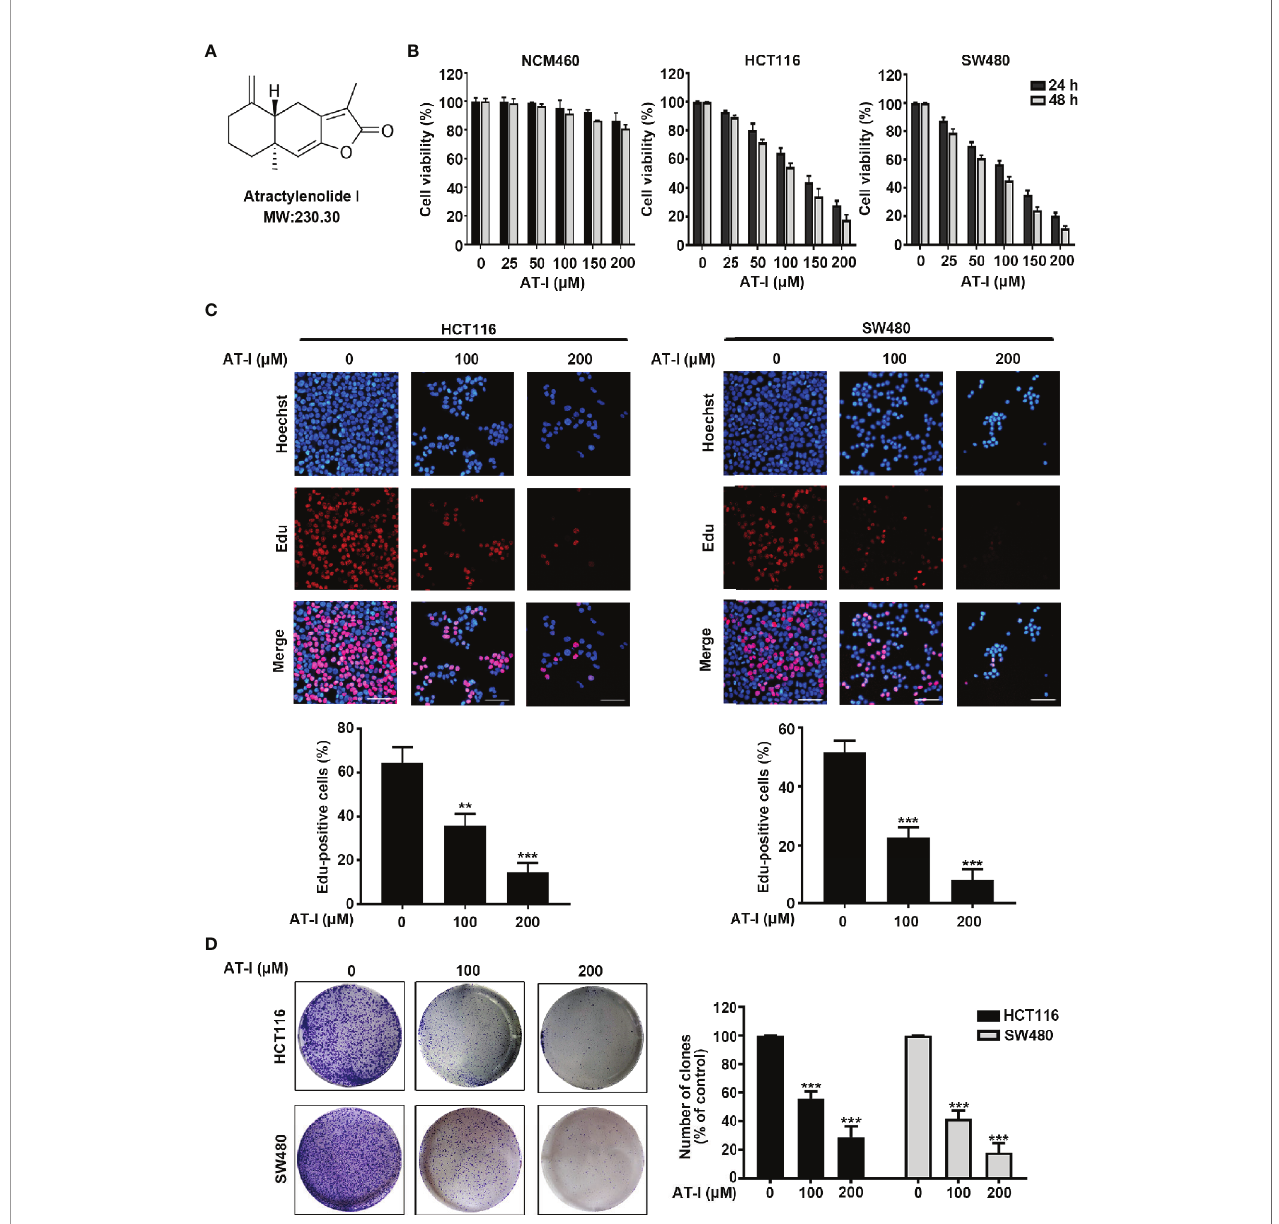
FIGURE 1 | AT-I inhibits human CRC cell proliferation. (A) Chemical structure of AT-I. (B) Viability of NCM460, HCT116 and SW480 cells measured using the CCK- 8 assay after treatment with different concentrations of AT-I for 24 or 48 h. (C) CRC cells were incubated with 0, 100, or 200 µM AT-I for 24 h, followed by further analysis using the EdU incorporation assay. Representative images are displayed. Scale bar = 100 m m. The EdU incorporation rate (the ratio of EdU-positive CRC cells to total Hoechst 33342-positive CRC cells) is shown. (D) Colony formation of CRC cells was determined following treatment with the indicated concentrations of AT-I. Left: representative images of the colonies. Right: statistical analysis showing the percentage of colonies relative to the control cells. ** p < 0.01 and *** p < 0.001 versus the control group without any